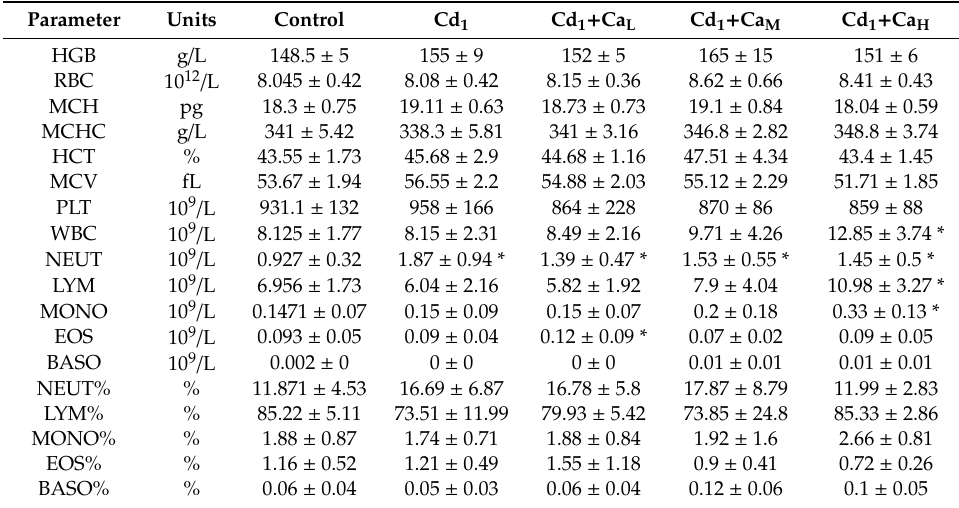
Table 4. Hematological parameters of female rats after 90 days in the study of Ca supplementation with dietary exposure to 1 mg Cd / Kg (Exp. 1).